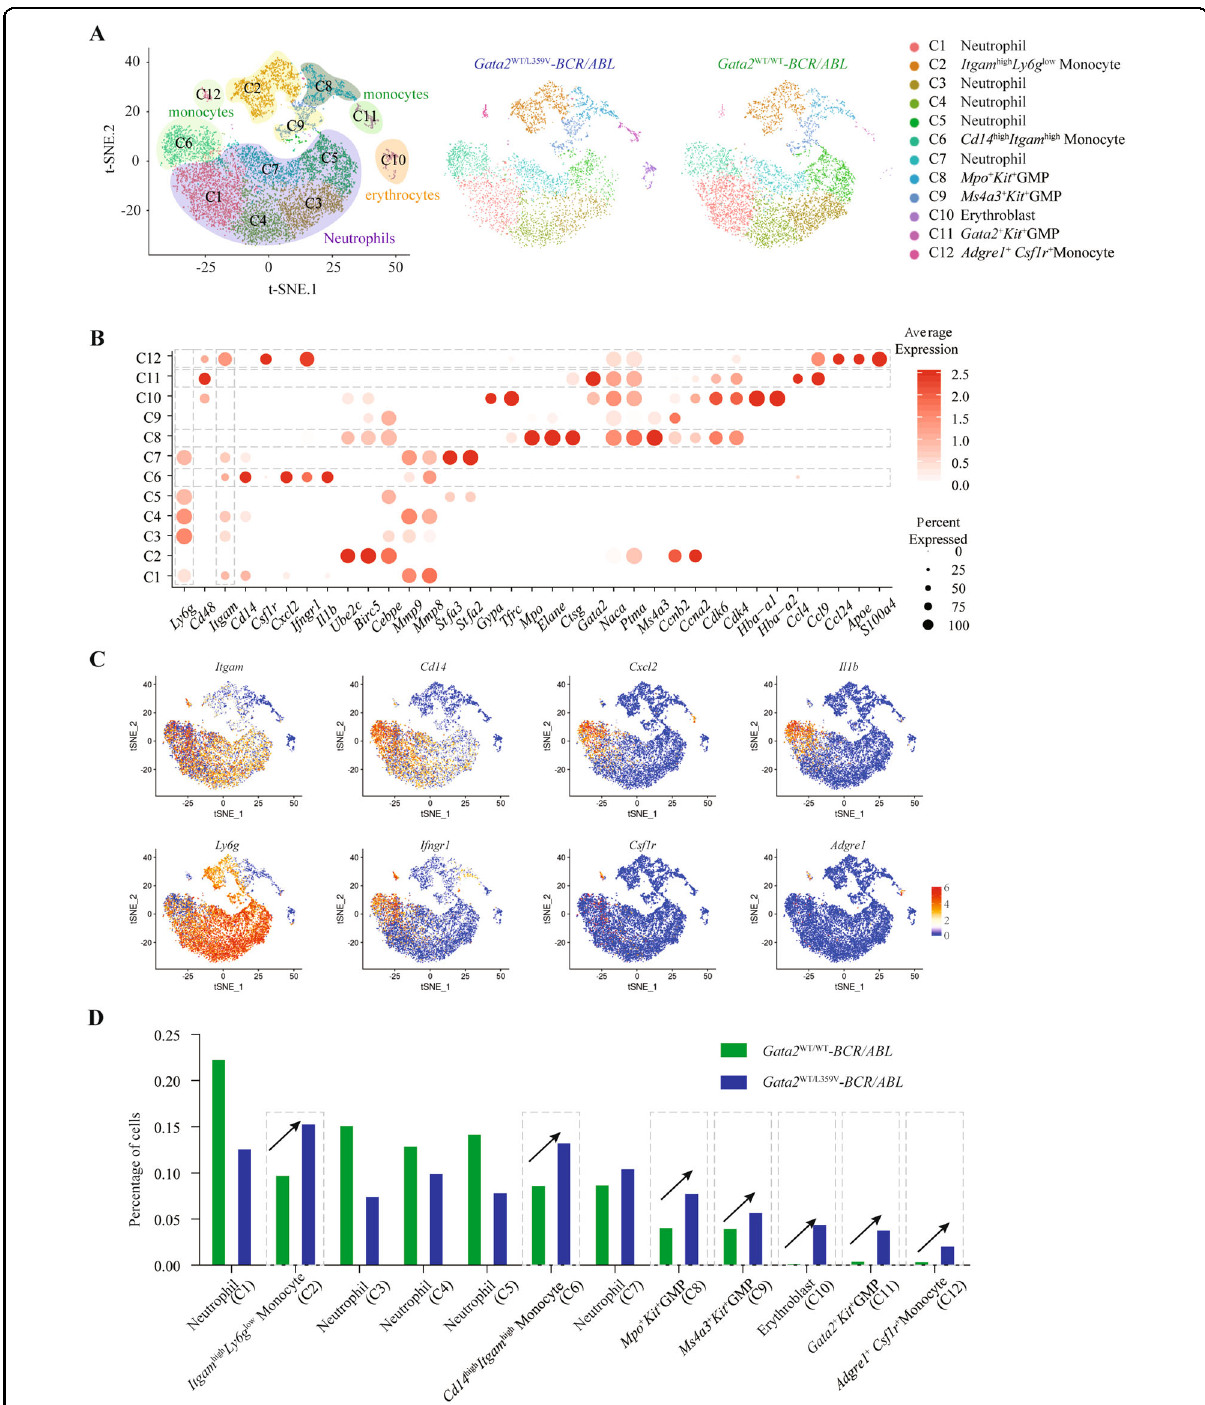
Fig. 7 Dynamic changes between leukemic cells of Gata2 WT/L359V - BCR/ABL and Gata2 WT/WT - BCR/ABL mice revealed by single-cell RNA-seq analysis. A t-distributed Stochastic Neighbor Embedding (t-SNE) showing 12 clusters of BM cells from Gata2 WT/L359V - BCR/ABL and Gata2 WT/WT - BCR/ ABL mice. The left panel showed the 12 clusters of the merged scRNA-seq datasets. The middle panels showed the separated illustration of the t-SNE map in Gata2 WT/L359V - BCR/ABL and Gata2 WT/WT - BCR/ABL group. The right panel showed the classi fi cation of the cell types. B Expression analysis of the cluster-speci fi c genes. Dot plot showing the expression of representative genes across the 12 classes of cells. C t-SNE showing the expression of representative genes in different classes of cells. D Comparison of the percentage of each class of cells between Gata2 WT/L359V - BCR/ABL and Gata2 WT/WT - BCR/ ABL